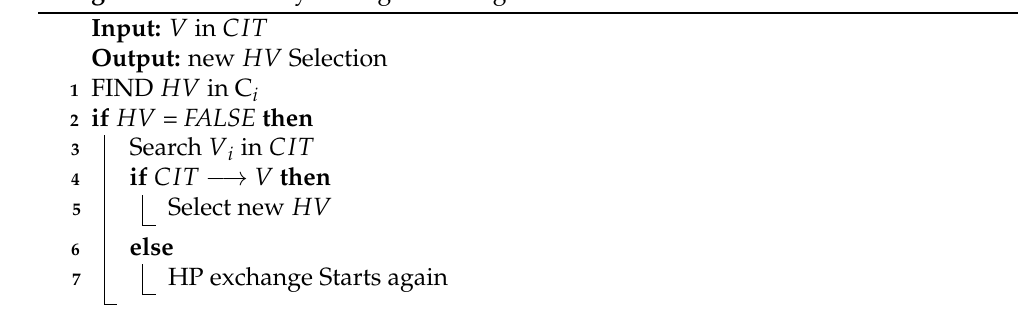
Algorithm 2: Mobility Management